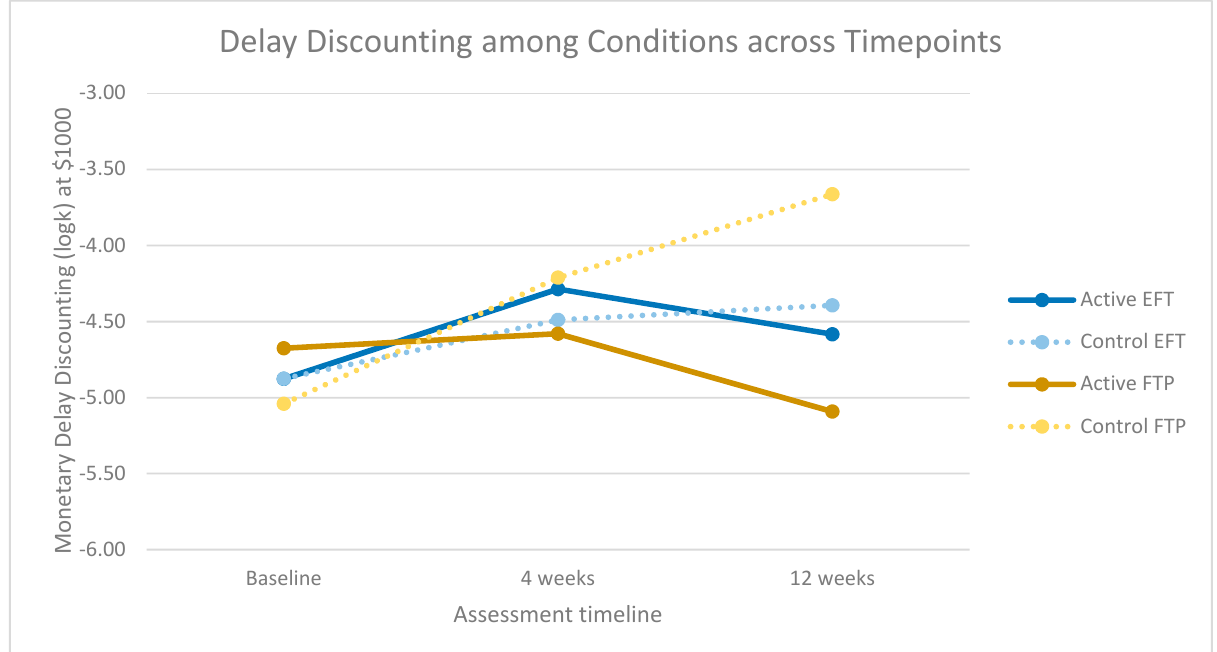
Figure 5. Monetary delay discounting using Mazur’s k hyperbolic equation at the $1000 amount for active and control EFT and FTP conditions from baseline through 12 weeks.